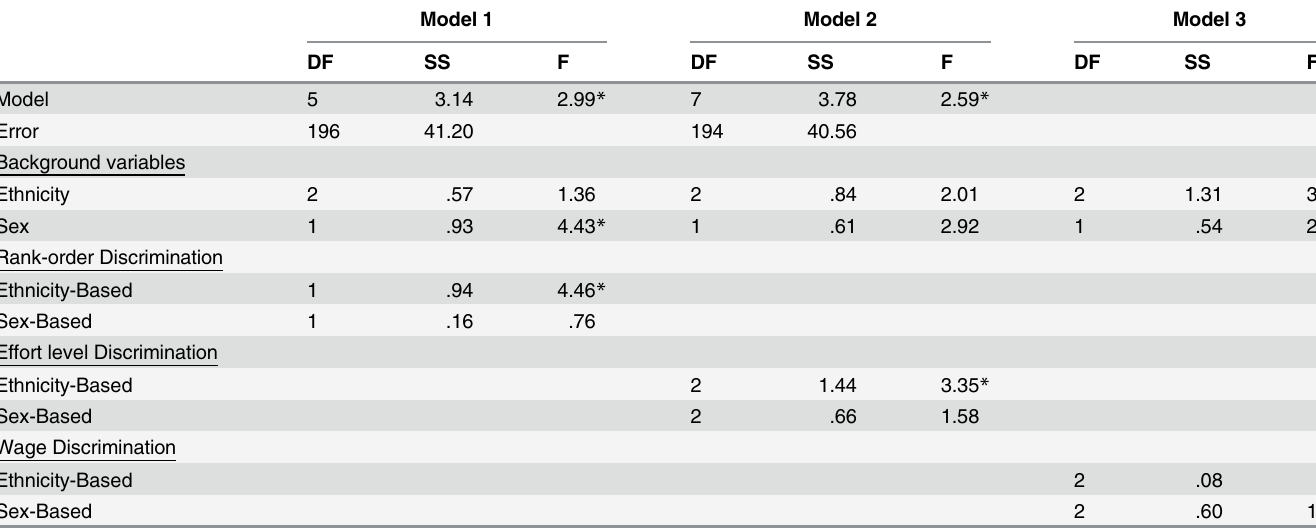
Table 4. General Linear Models Predicting Change in